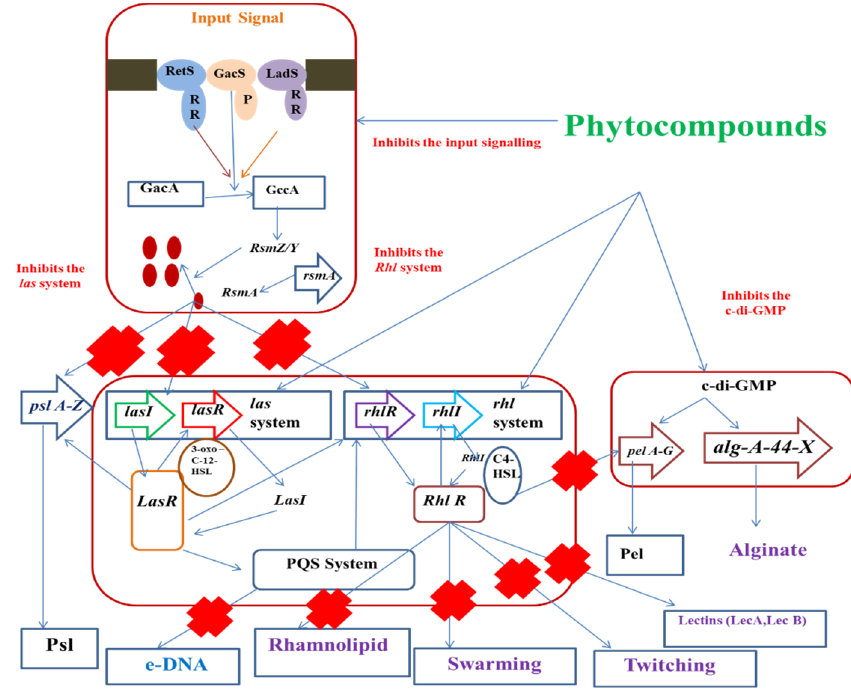
Figure 2. Phytocompound mediated inhibition of QS